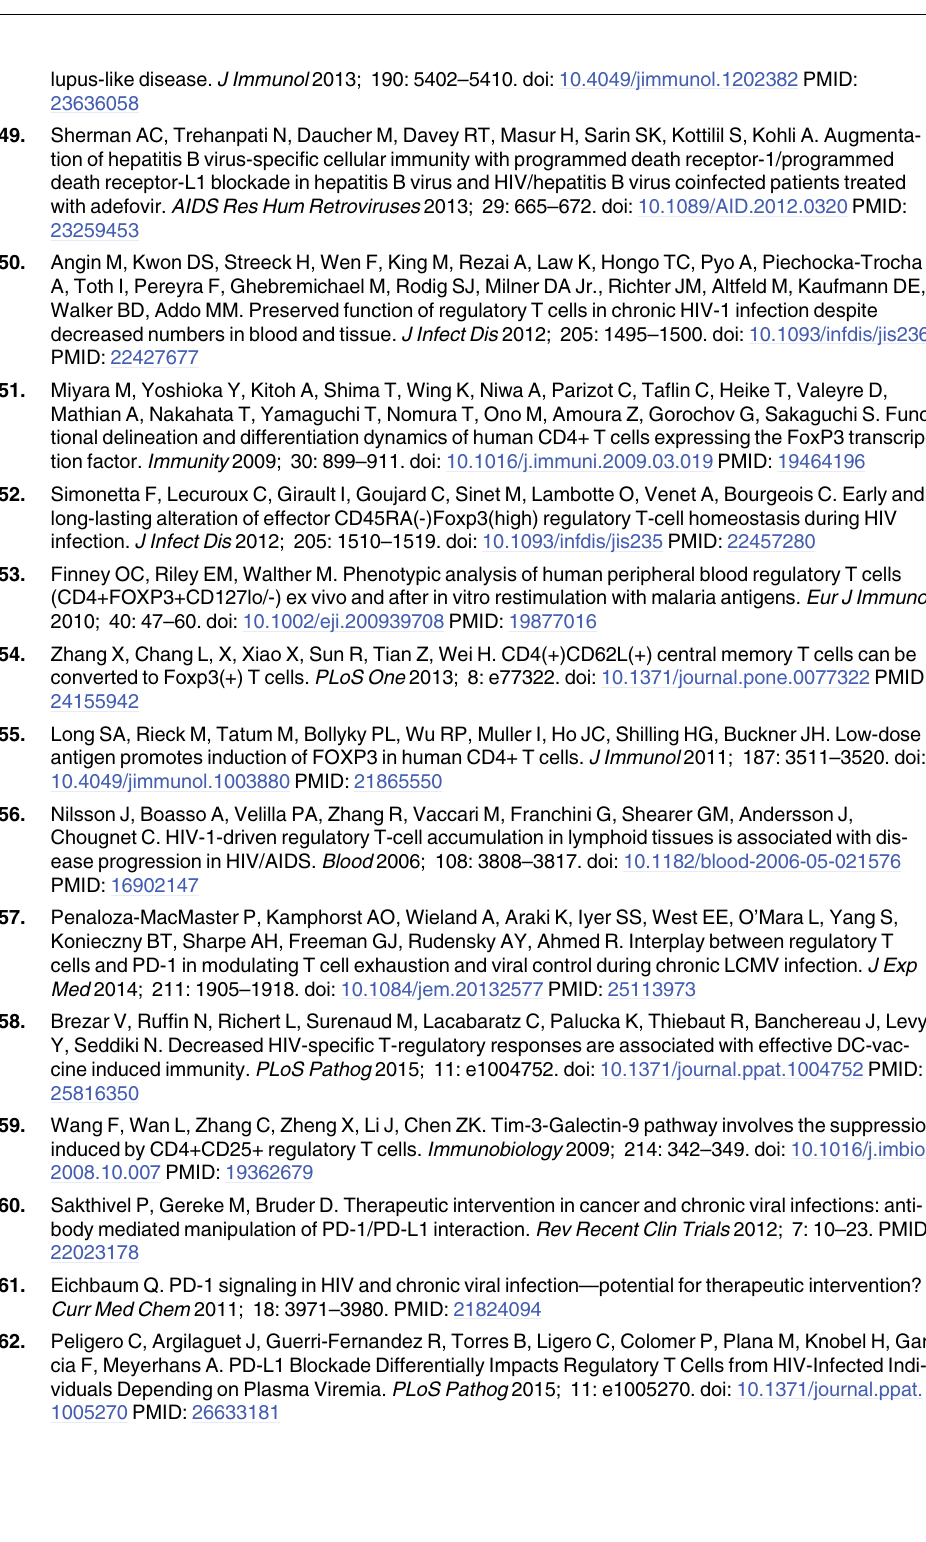
PLOS Pathogens | DOI:10.1371/journal.ppat.1005995 November 9,